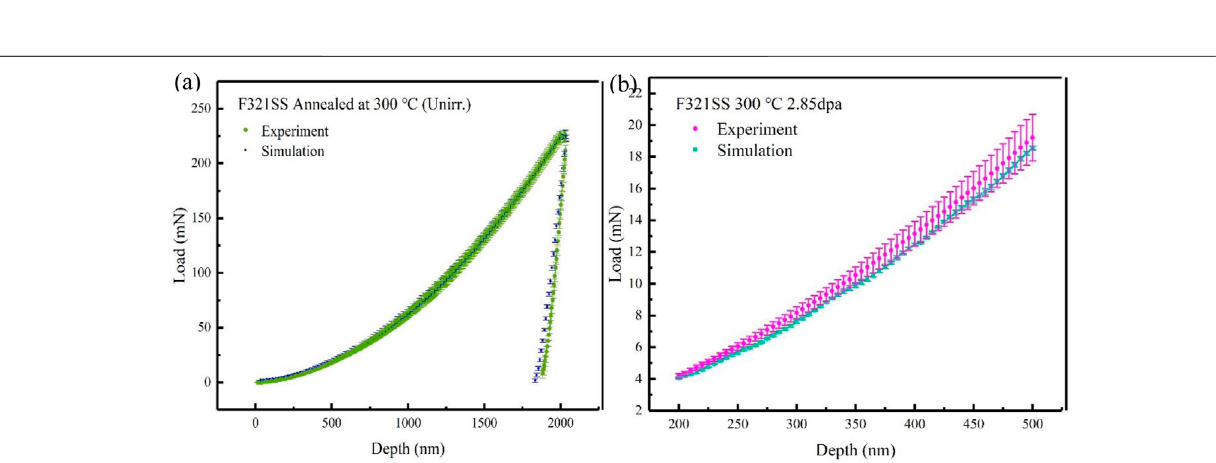
Frontiers in Materials |